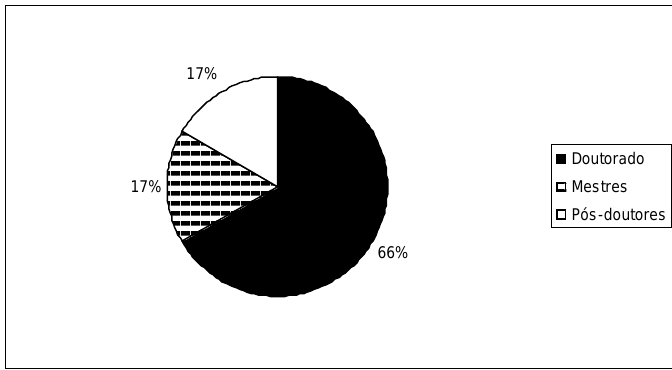
Figura 5. Distribuição da titulação dos responsáveis pelos grupos de pesquisa.